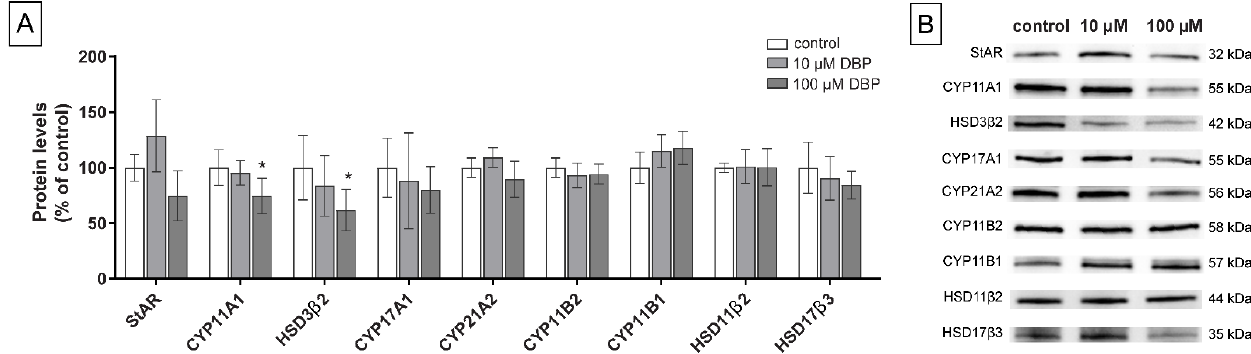
Figure 5. Levels of nine different steroidogenic proteins were measured by western blot ( A ) in H295R cells exposed to 0 (0.1% DMSO, solvent control), 10, or 100 µM DBP for 48 h, with stimulation of the steroidogenesis by 0.1 mM dbcAMP. Values represent mean ± S.D. from six replicates per treatment. Representative blots for each protein are shown ( B ). Total protein stain was used as a loading control. The statistically significant differences from the control are indicated as follows: * p < 0.05 (One-way ANOVA followed by Dunnet’s test).